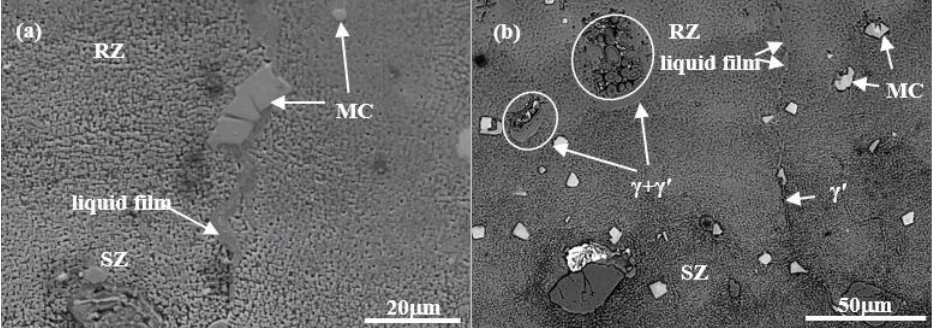
Figure 3. Liquid film and phase distribution in HAZ: ( a ) liquid film and MC carbides and ( b ) liquid film and γ + γ′ eutectics.